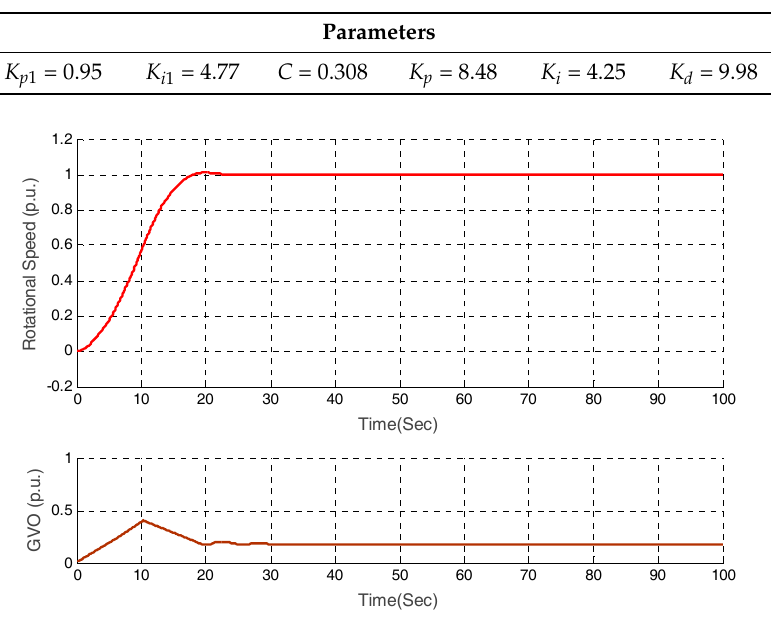
Table 12. Optimized parameters for integrated star-up method.